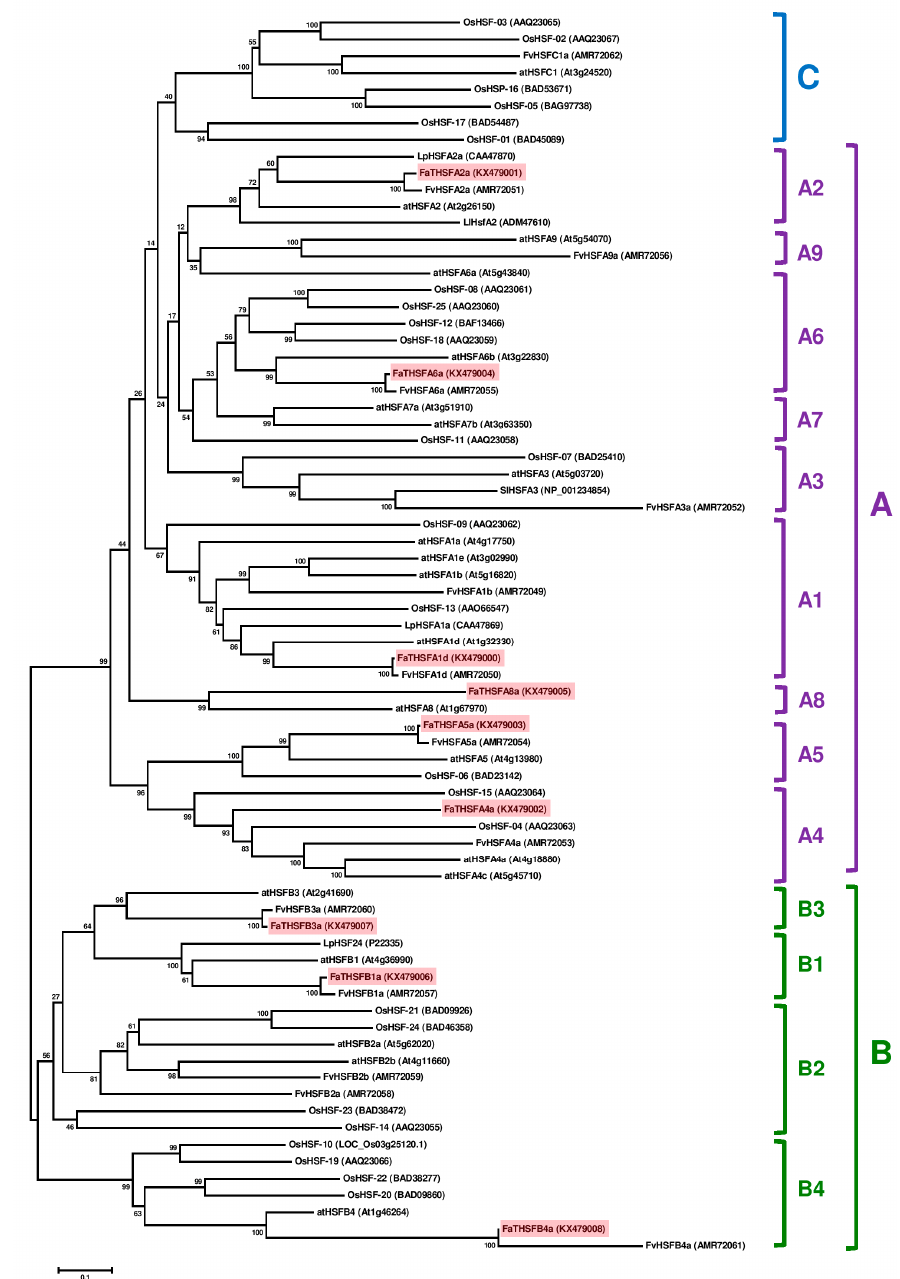
Figure 4. Phylogenetic relationships among the nine full-length FaTHSF genes identified in F. × ananassa Duch. cv. Toyonoka and other plant HSF proteins. The phylogenetic tree was established by the neighbor joining method by using MAGA 6.0 software. Numbers on major branches indicate bootstrap percentages for 1000 replicate analyses. The tree shows three major clades: class A (A1–A9 subclades), class B (B1–B4 subclades), and class C. Nine unigenes with full-length HSFs identified in this study are highlighted in pink. The abbreviations for the names of different species are as follows: at, Arabidopsis thaliana ; Fv, Fragia vesca ; Lp, Lycopersicon peruvianum ; Os, Oryza sativa ; and Sl, Solanum lycopersicum . The accession numbers for the corresponding genes are provided in parenthesis with the protein names.